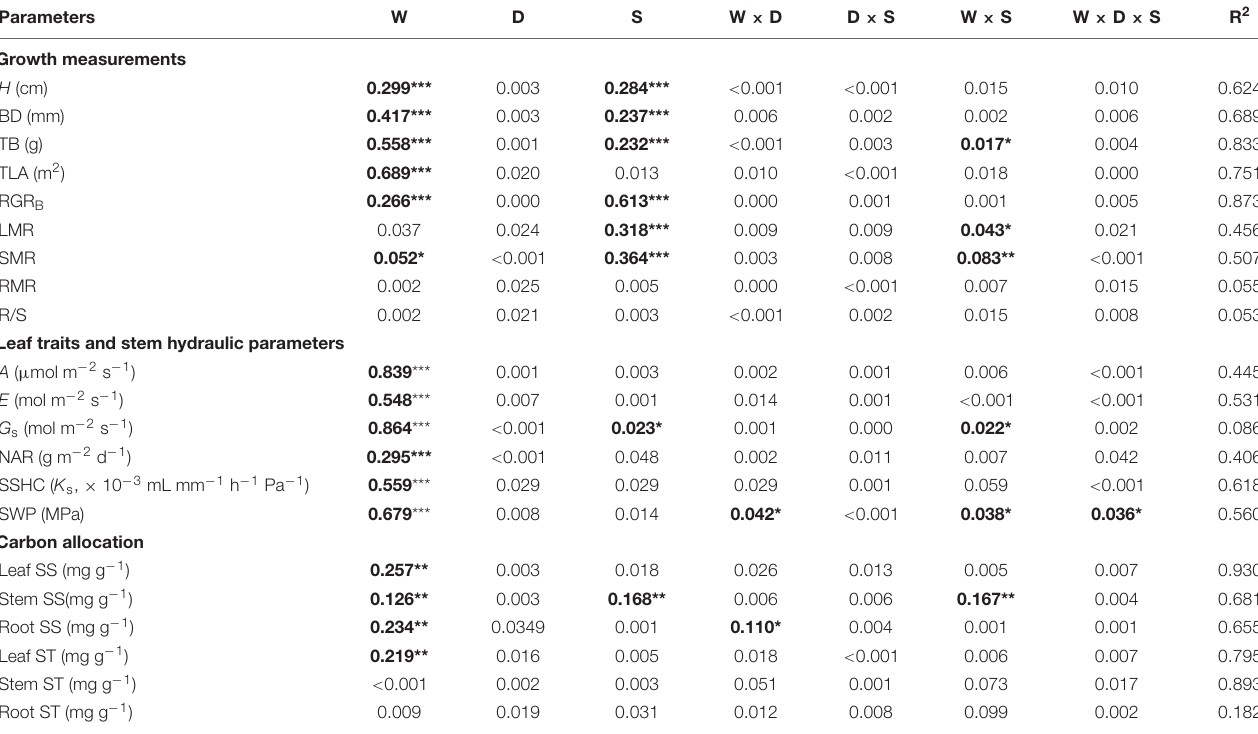
TABLE 2 | The proportion of explained variation from water availability (high water availability vs. low water availability), defoliation (defoliation vs. non-defoliation), plant size (small vs. large) and their interactions on 21 measured traits for A. fruticosa seedlings.